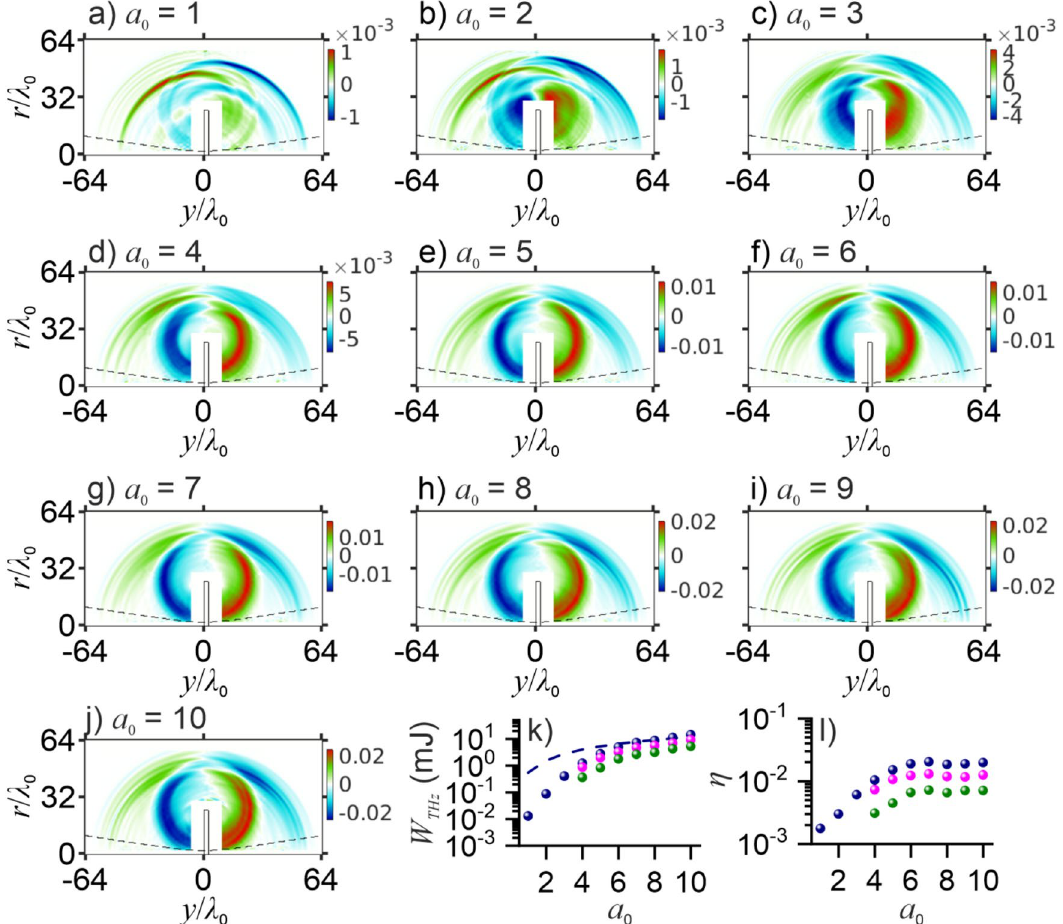
Figure 7. ( a – j ) Spatial distributions of the THz field B 0 θ ( y , r ) at t = 85 T 0 for a 0 as specified in the panels. The dashed line is the FWHM radius of the driver laser beam propagating in space with no plasmas. ( k , l ) THz output energy ( k ) and laser-to-THz energy conversion efficiency ( l ) as functions of a 0 : (green circles) the CTR component, (pink circles) antenna-like plasma emission, and (blue circles) overall THz output. The ∝ Φ( I 0 λ 0 2 ) scaling is shown by the dashed